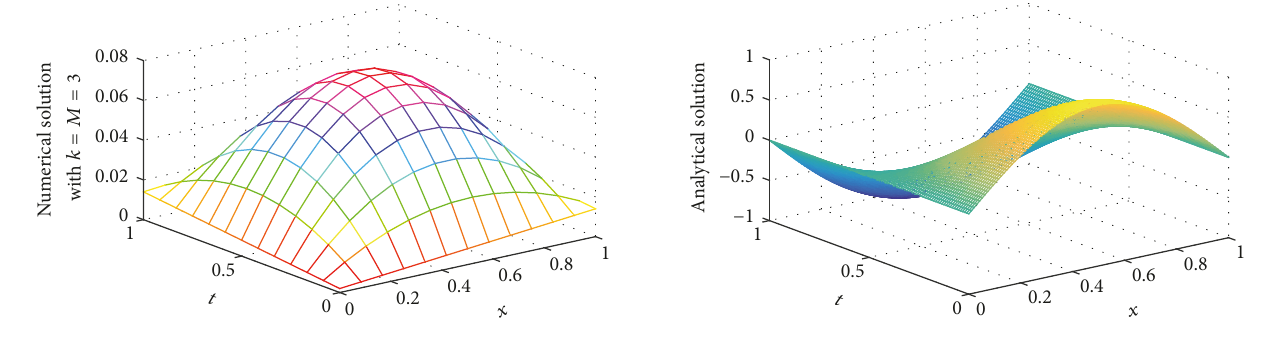
Figure 3: Numerical solution with 𝑘 = 𝑀 = 3 .